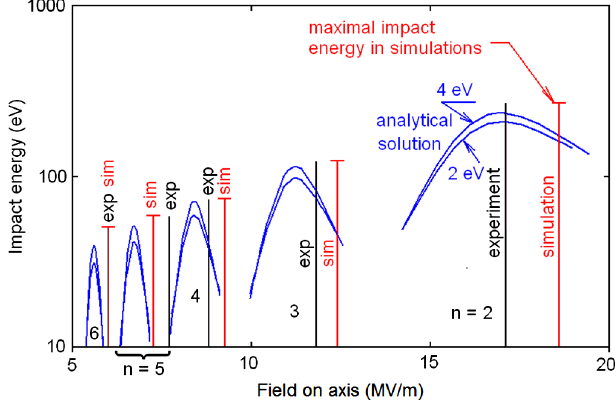
FIG. 7. Comparison of results from [1] and analytical results for 2–6 orders of